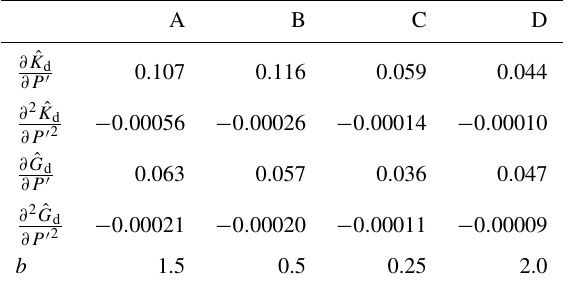
Table 4. Derivatives for the dry frame elastic moduli with respect to effective confining pressure (calculated for elastic moduli in GPa and effective pressure in MPa), and b values representing the slope of the log–log permeability–pressure